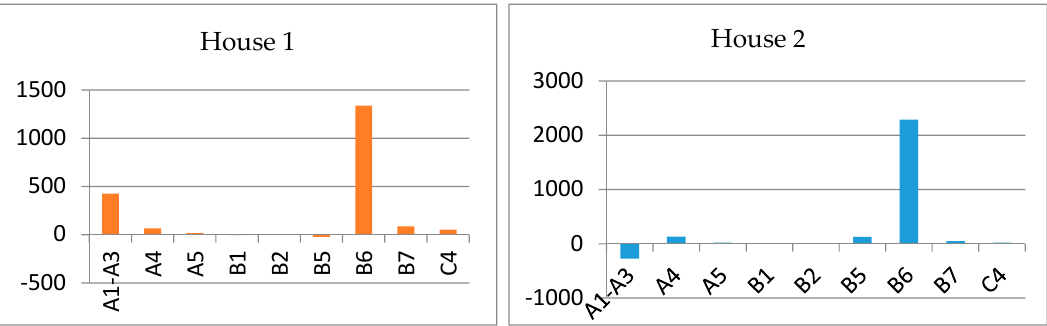
Figure 2. LCA module impacts of GWP (kg CO 2eq ), A1–A3 Product Stage; A4 Transport of Equipment